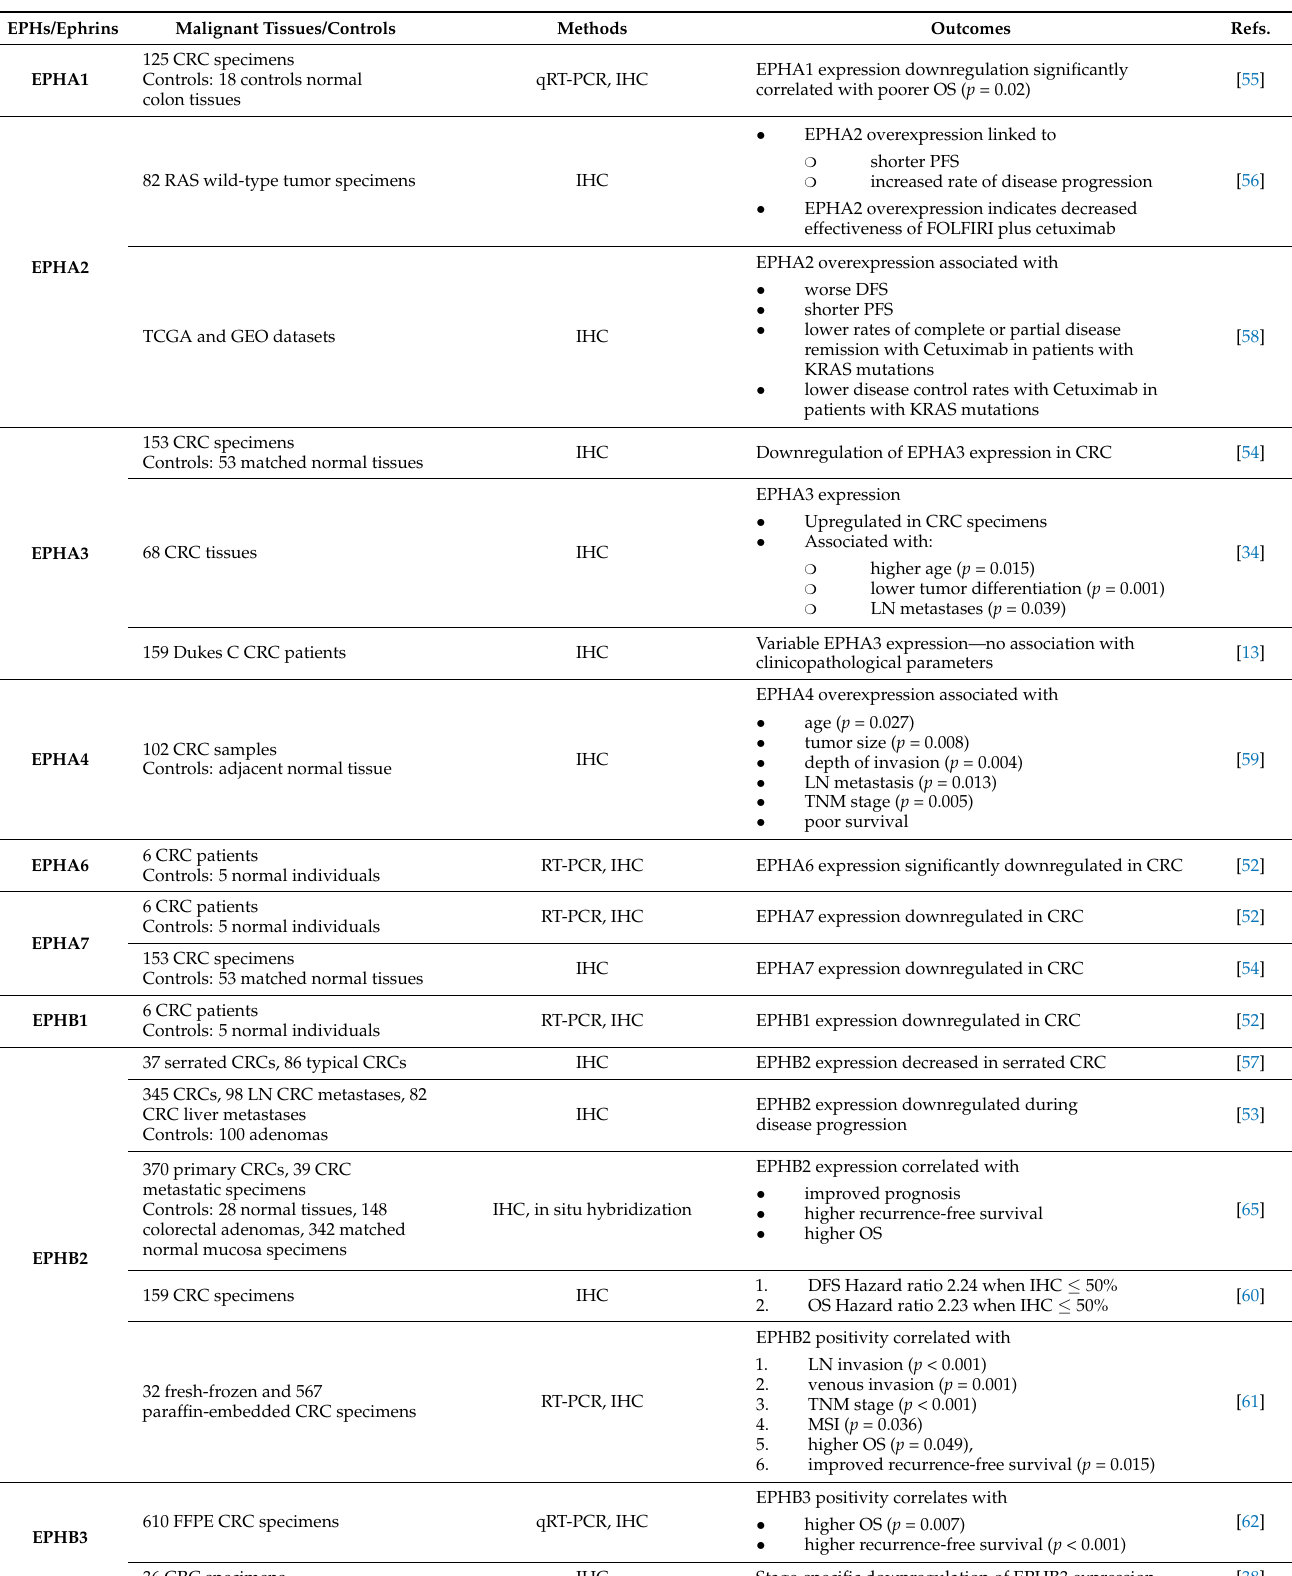
Table 2. EPHs/ephrins studied in patients’ tissues, methods utilized, and results